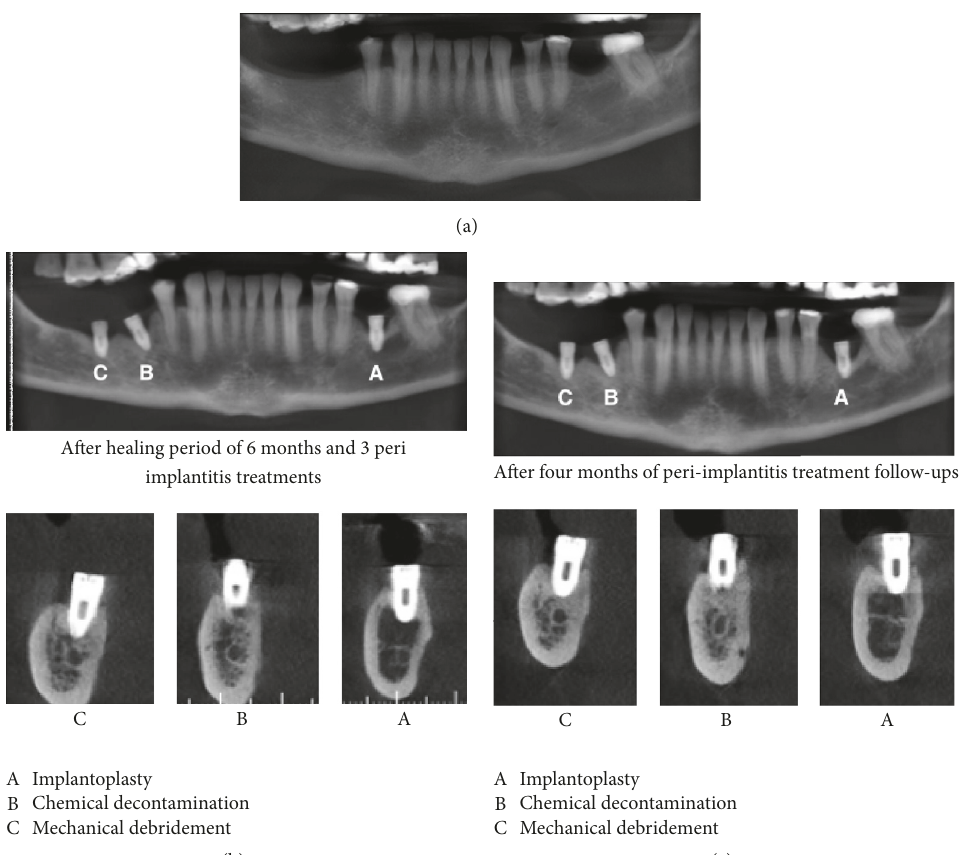
Figure 1: (a) Initial tomography, (b) 6 months’ implant after placement and peri-implantitis treatments, (c) 4 months’ after different peri- implantitis treatments. (A: implantoplasty, B: acid treatment, and C: debridement).